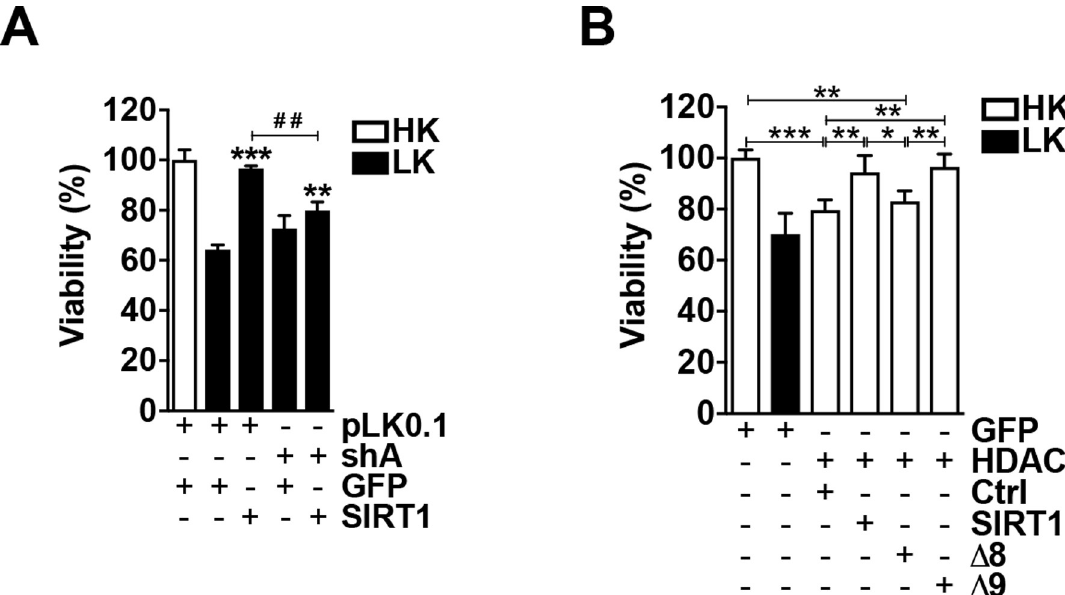
Fig 4. SIRT1 requires HDAC1 to protect CGNs against apoptosis. A . SIRT1 requires HDAC1. GFP or SIRT1-Flag were co-expressed in a 1:2 ratio with either a control shRNA (pLK0.1) or a distinct HDAC1 shRNA (sh A) ( �� p < 0.01 and ��� p < 0.001 as compared to GFP/ pLK0.1 treated with LK; ## p < 0.01 as compared to SIRT1/pLK0.1 treated with LK; n = 3). B . SIRT1 and Δ 9, but not Δ 8, rescue HDAC1 toxicity. CGNs were transfected with GFP or co-transfected with HDAC1-GFP and either a control vector (Ctrl, 3xFLAG), SIRT1-Flag, Δ 8-Flag, or Δ 9-Flag in a 1:2 ratio ( � p < 0.05, �� p < 0.01, ��� p < 0.001; n = 3).